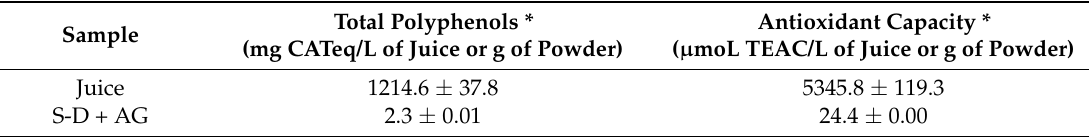
Table 2. Total polyphenols content (TP) and antioxidant capacity of the juice and powder obtained by spray-drying (S-D) with the addition of arabic gum (AG).